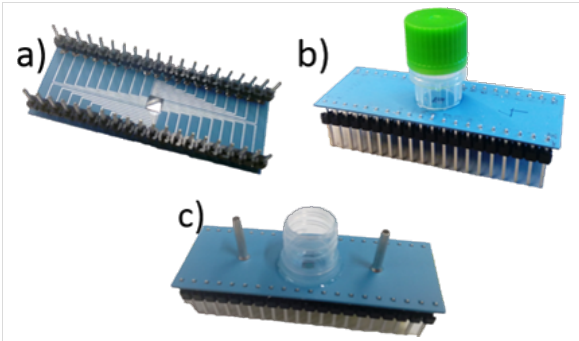
Figure 3: (a) Bottom side of the LTCC package showing the rear side of the sensor chip. (b) The sensor chip in the LTCC package connected. The active side of the chip is inside the cell culture vial glued on the top of the LTCC package. (c) Prototype of the package with integrated microfluidic